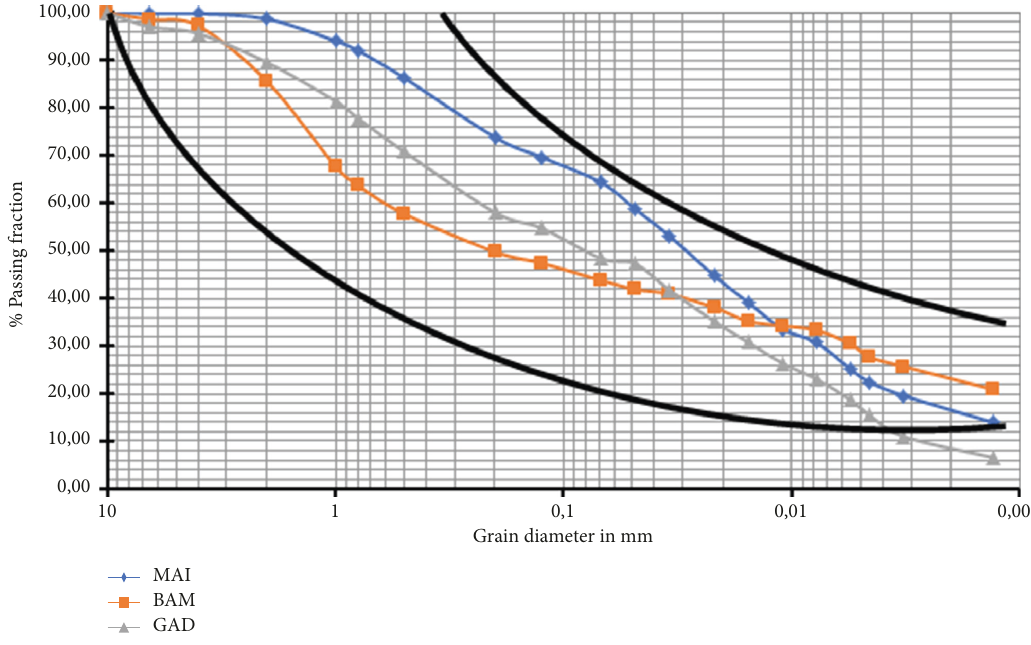
Figure 6: Complete particle size distribution curve of MAI, BAM, and